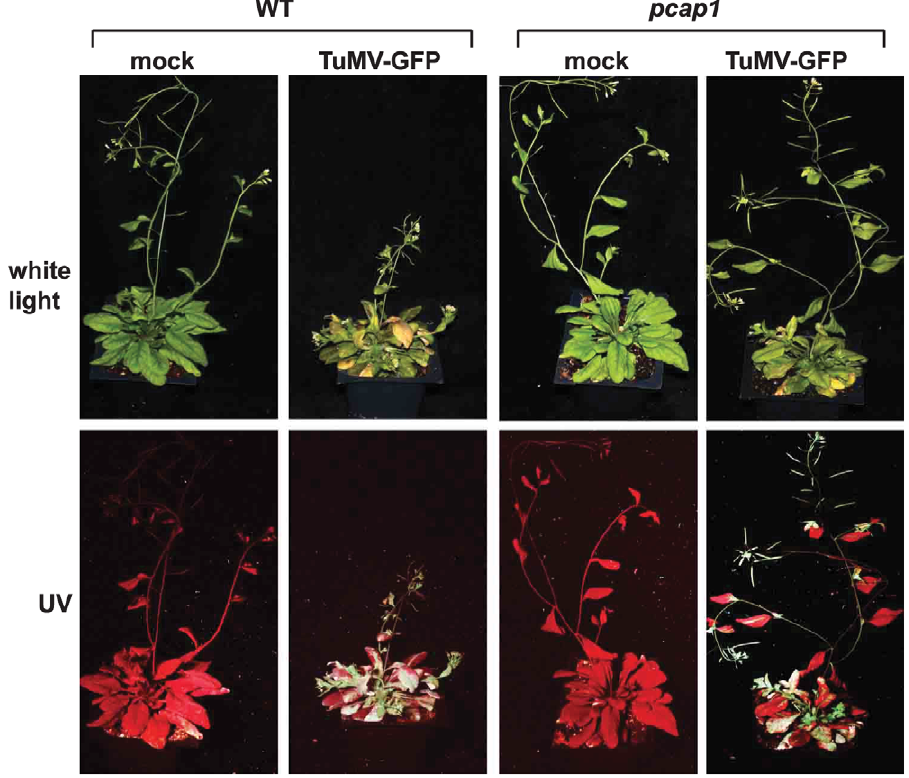
Figure 8. TuMV-GFP infection of wild type and pcap1Arabidopsis plants. Plants were mock inoculated or inoculated with TuMV-GFP and photographed under white light or UV light at 30 dpi. Wild-type (WT), PCaP1 knockout ( pcap1